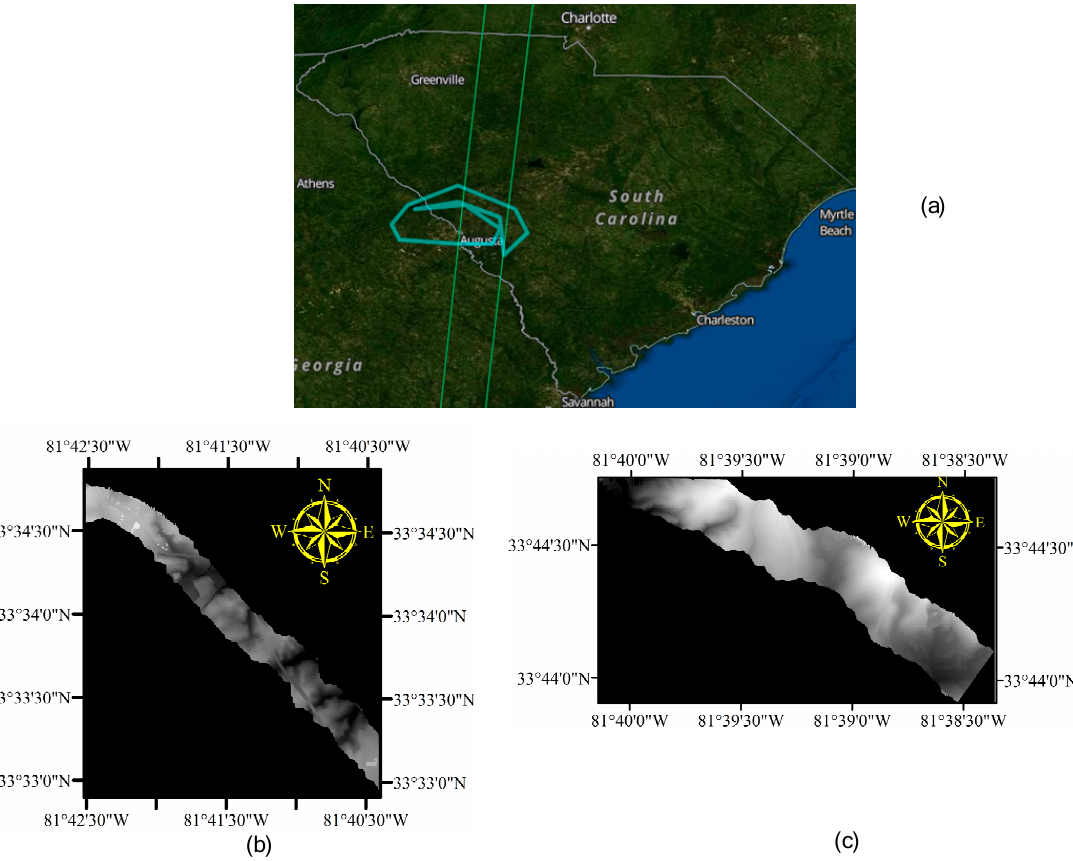
Figure 3. ( a ): Trajectories of Advanced Topographic Laser Altimeter (ATLAS) data (green) and G-LiHT data (blue) depict the location of the study area NASA EARTHDATA. ( b ): G-LiHT data named AMIGACarb_Augusta_FIA_Sep2011_l16s597_DTM.tif as reference airborne data. ( c ): G-LiHT